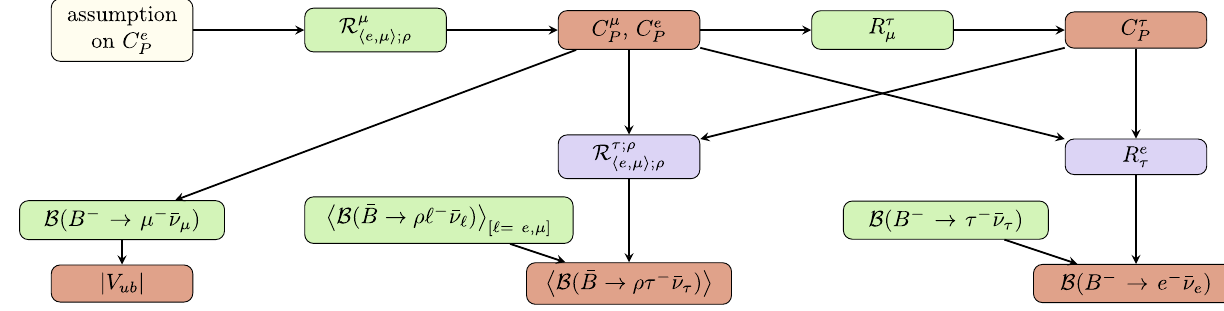
(cid:28) [ (cid:2) = e ,μ ]